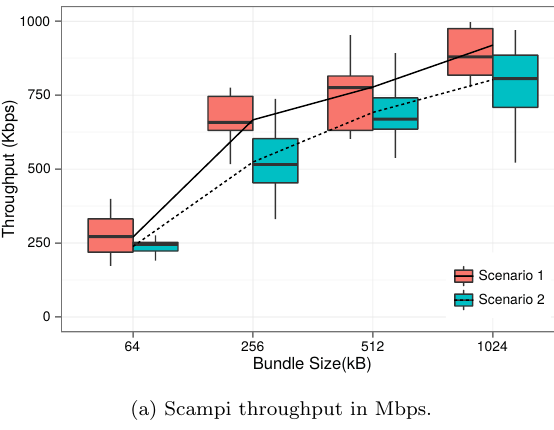
(a) Scampi throughput in Mbps.